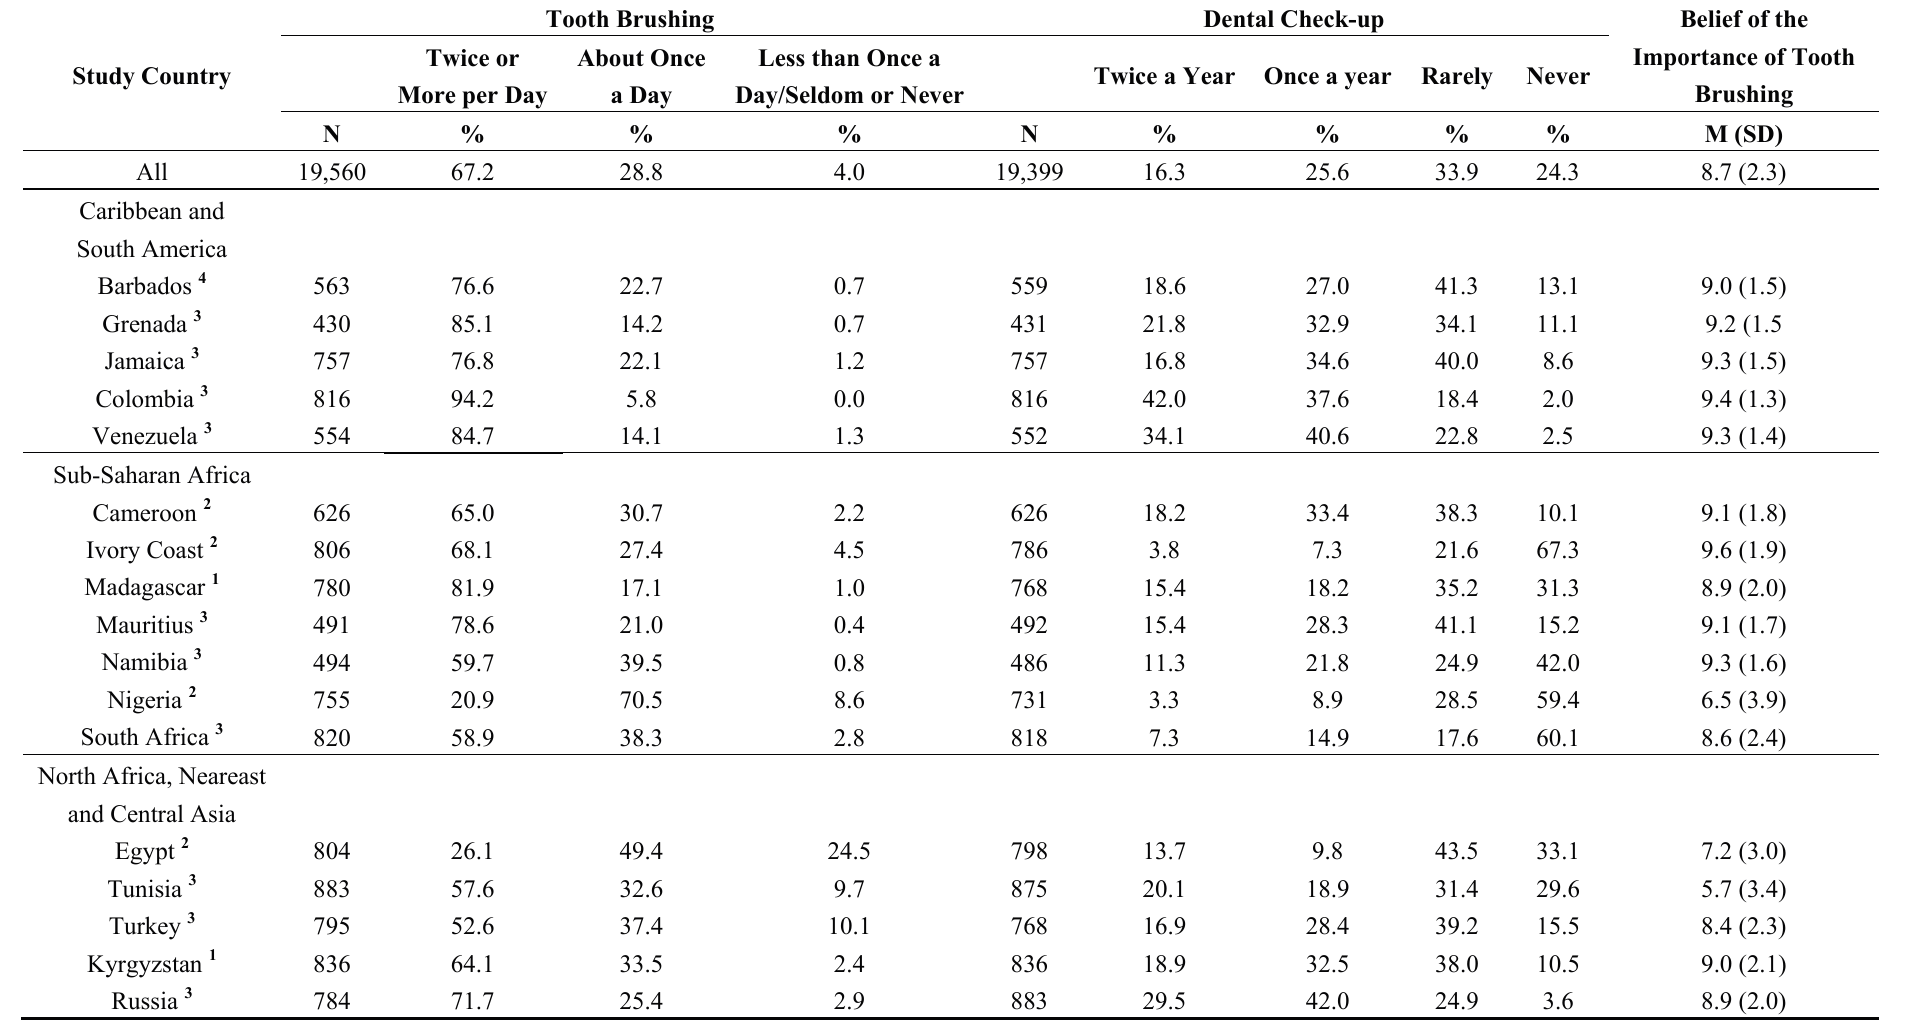
Table 1. Oral health behaviour prevalence by